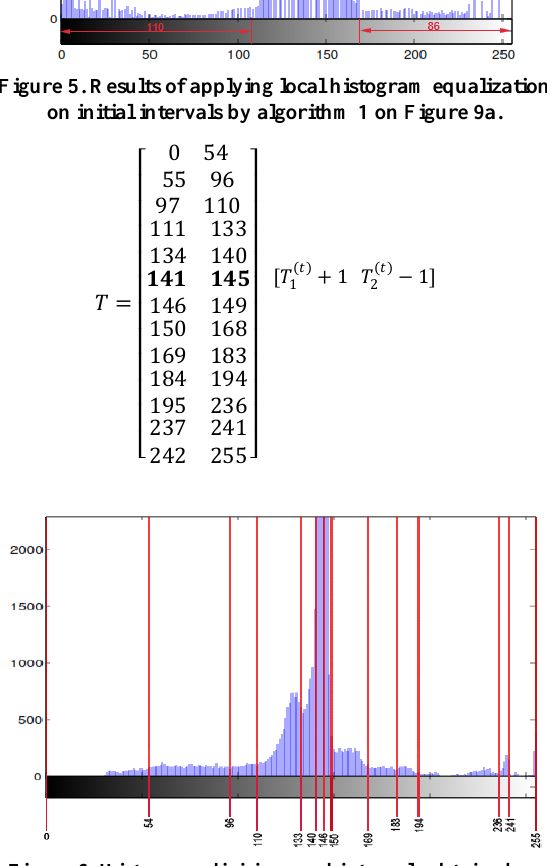
Figure 6. Histogram divisions and intervals obtained on Figure 9a after re-implantation of algorithm 1 for intervals larger than